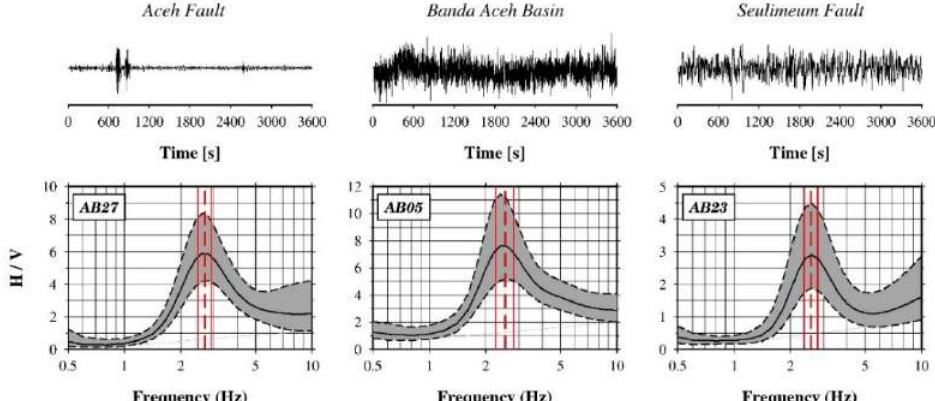
Fig. 6: Three recording examples in AB27, AB05, and AB23 show different waveforms depending on site properties. The spectrum analysis of AB27, AB05, and AB23 generated a normal curve graph of amplitude (A) and frequency (f)